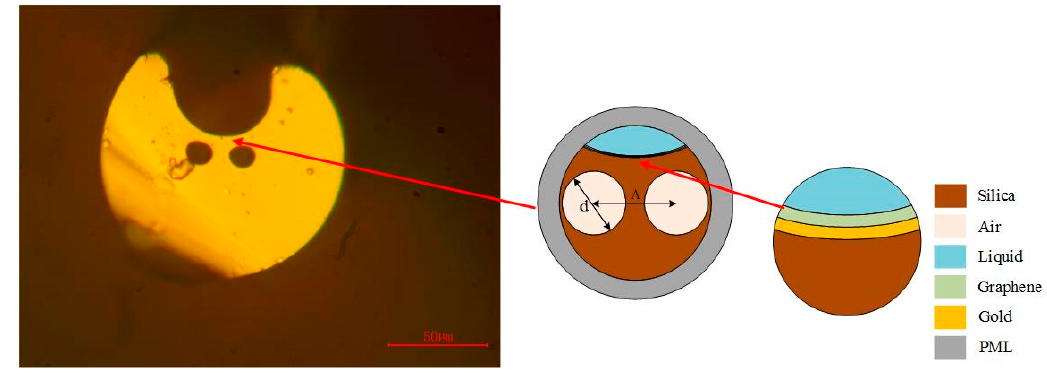
Figure 1. Structure of the sensor.